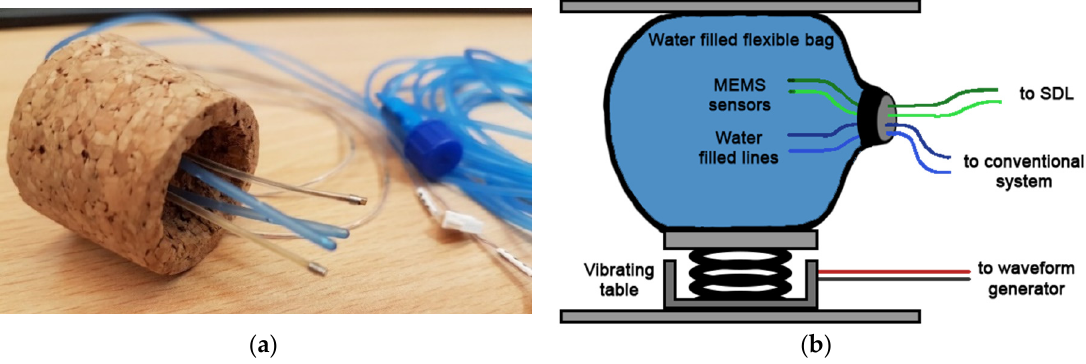
Figure 5. ( a ) The MEMS sensor probes and conventional bladder pressure catheters inserted through the cork to be assembled into the water ‐ filled flexible bag. ( b ) Schematics of the experimental setup.